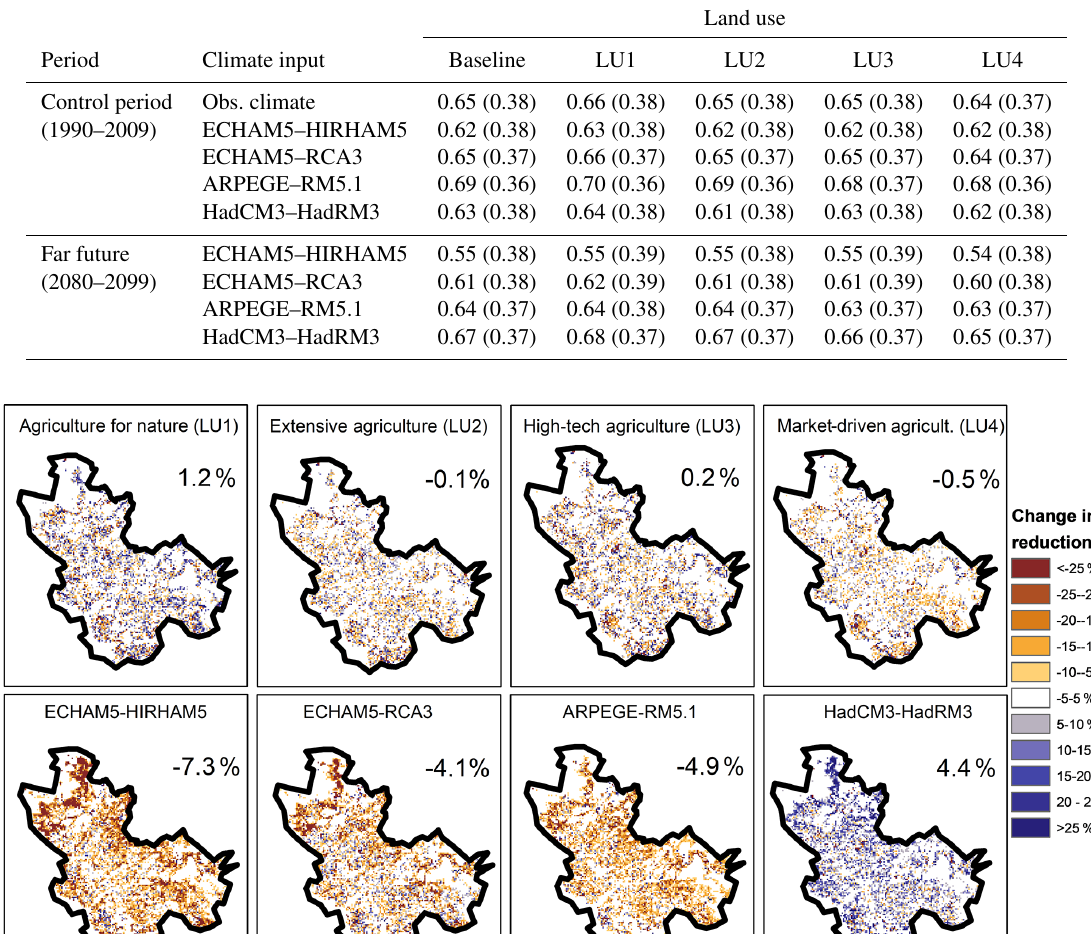
Table 4. Mean and standard deviation (in parentheses) across the catchment for each of the nitrate reduction potential maps (proportion of nitrate reduced).